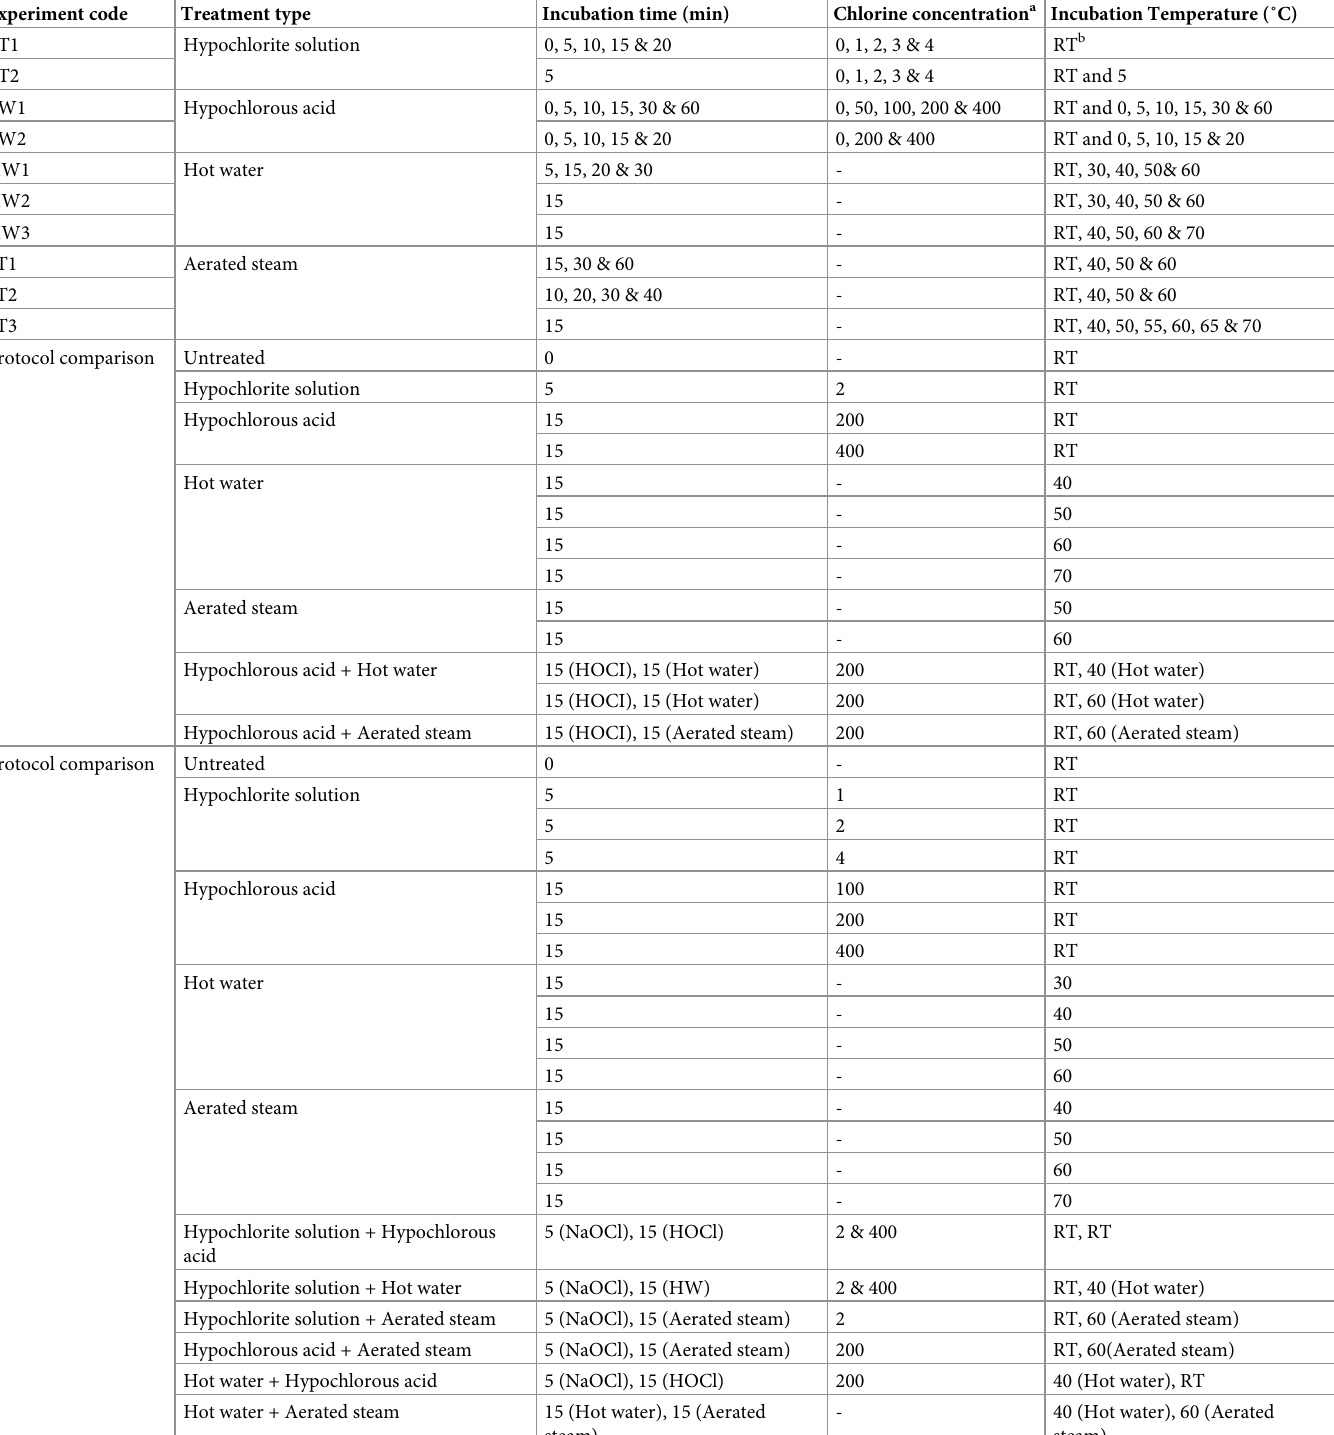
Table 1. Outline of seed treatment experiments and treatment parameters conducted in this study. Experiment code